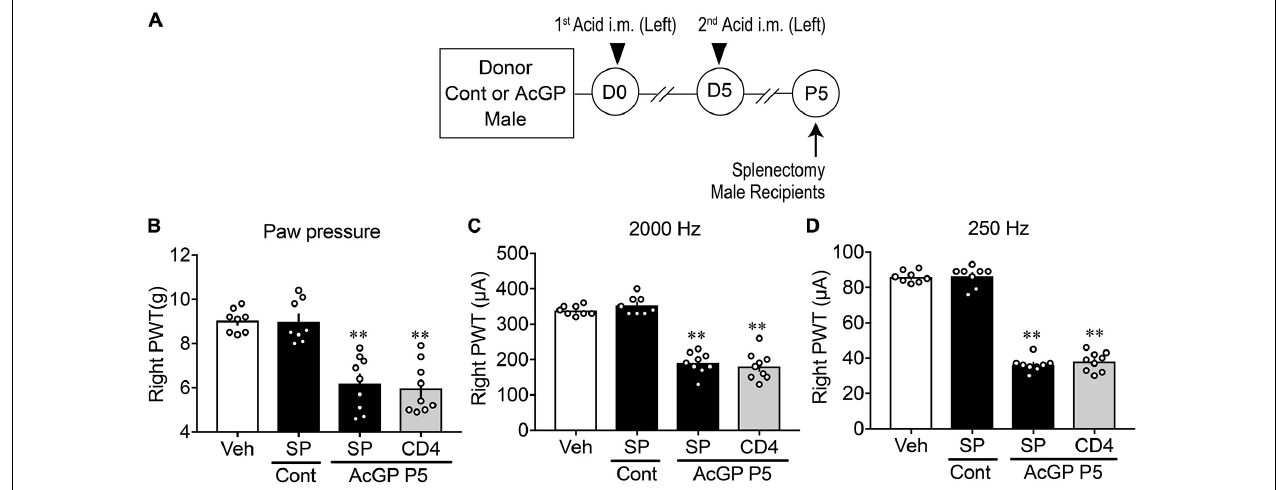
FIGURE 7 | Reproduction of allodynia by splenic CD4 + -cells. (A) Experimental design. Splenocytes were isolated at P5 and then dissociated and separated by MACS beads with anti-CD4 or anti-F4/80 antibody. Splenocytes and separated cells were used for the study of gene expression and injection to naive male mice for paw pressure and EPW tests. (B–D) Allodynia by splenic CD4 + T cells. Results represent the mechanical allodynia (B) , and hypersensitivity to electrical stimulation of 2,000 Hz (C) and 250 Hz (D) on the right side of naive male mice at day 1 after cell injection. (B–D) ∗∗ p < 0.01, compared with splenocytes (SP) Cont, in one-way ANOVA followed by Tukey’s multiple comparisons test ( n = 8–9). The dots in the column represent number of animals. Veh, the results in naive mice given PBS, which was used for the suspension of splenocytes or purified cells; SP and CD4: splenocytes and CD4 + cells, respectively; Cont and AcGP: the treatments with control (pH 7.2) and acid saline (pH 4.0) in donor male mice. AcGP, acid saline-induced FM-like generalized pain; PWT, paw withdrawal